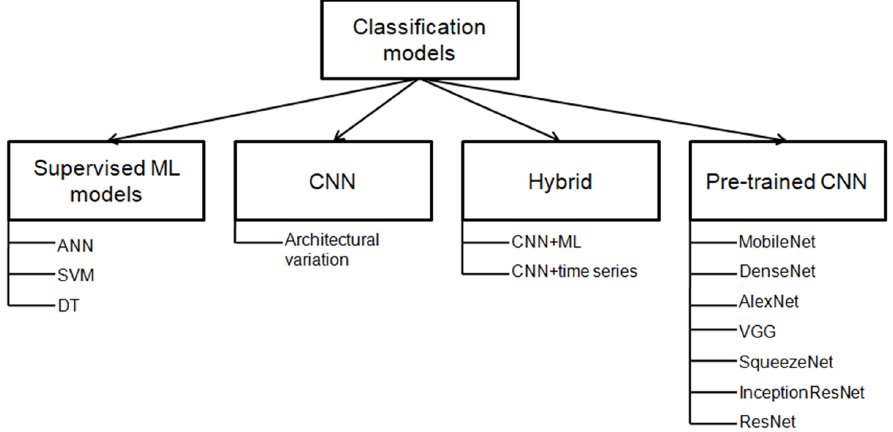
Figure 3. Types of techniques used for nutrient deficiency classification in crops (in previous stud-